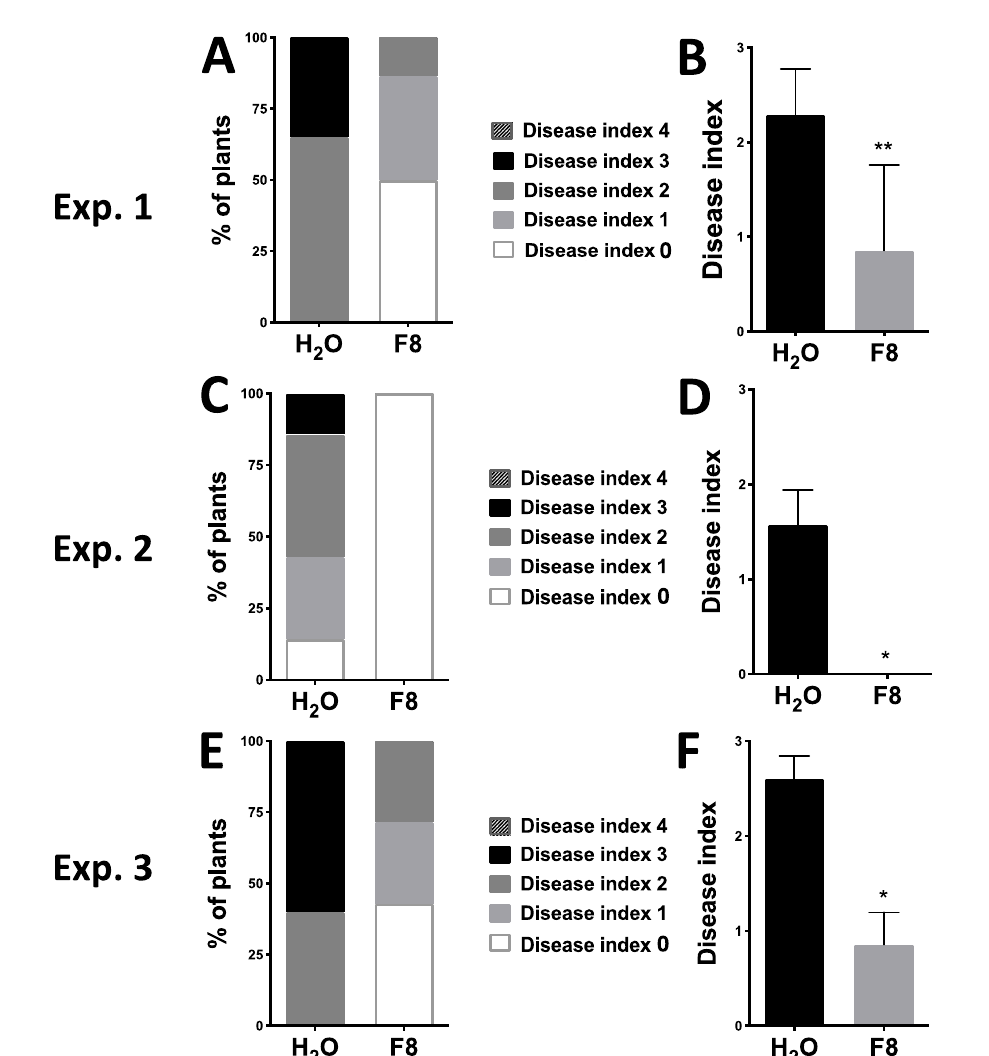
Figure 1. Symptoms on H 2 O or F8-culture filtrate pretreated Yu-Nu tomato plants inoculated with tomato yellow leaf curl Thailand virus (TYLCTHV). The level of disease index was recorded at 28 days post inoculation (dpi) in the H 2 O or F8-culture filtrate pretreated group ( A , C , E ). The average disease index of plants inoculated with TYLCTHV according to the specified pretreatment groups ( B , D , F ). Data represent mean ± SEM; n = 6–7 biological replicates. Student’s t -test was used for comparative analysis of the data for the F8-culture filtrate pretreated group and the H 2 O pretreated control group. * p < 0.05; ** p < 0.01.